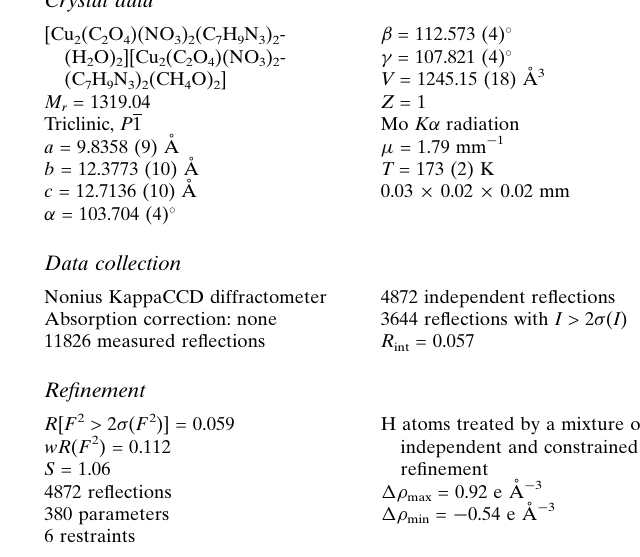
Experimental Crystal data